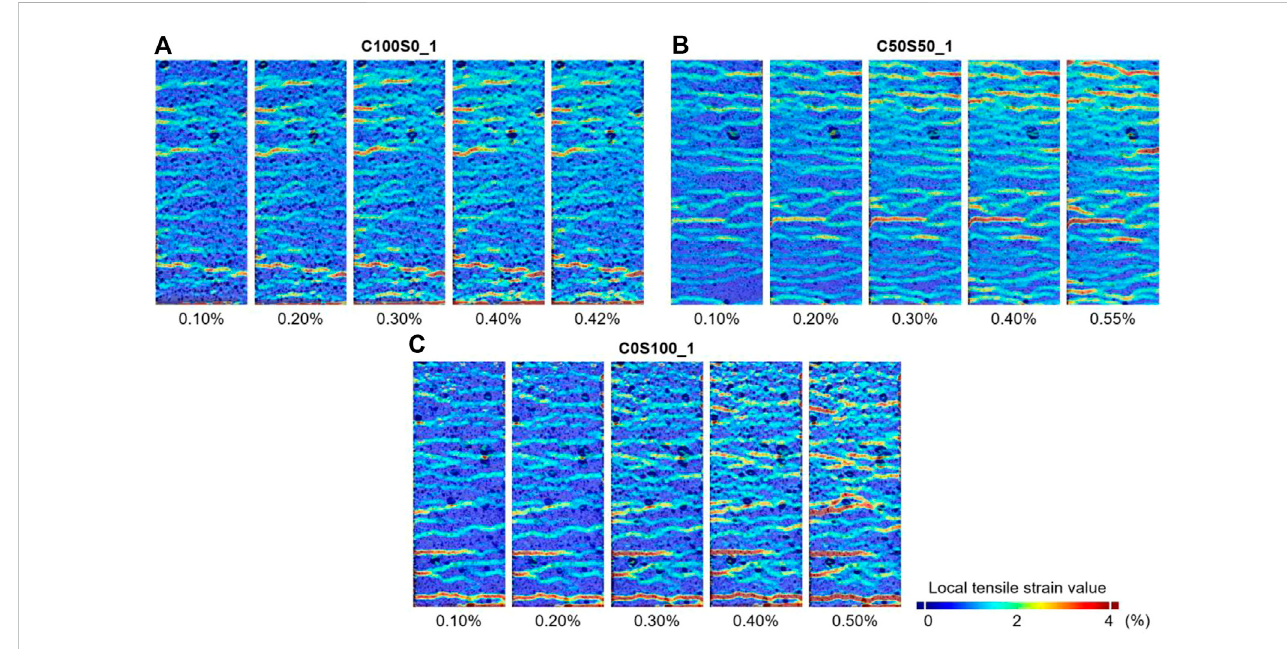
FIGURE 10 DIC strain fi elds of SH-UHPGC at different strain levels (A) C100S0, (B) C50S50, and (C)